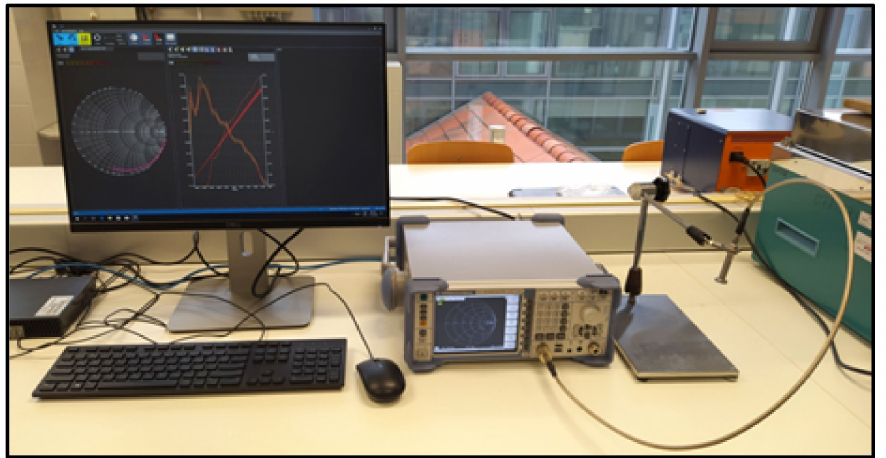
Figure 4. The open-ended coaxial probe, ZVL-3 vector network analyzer, and the SPEAG DAK analyzing software (from right to left).